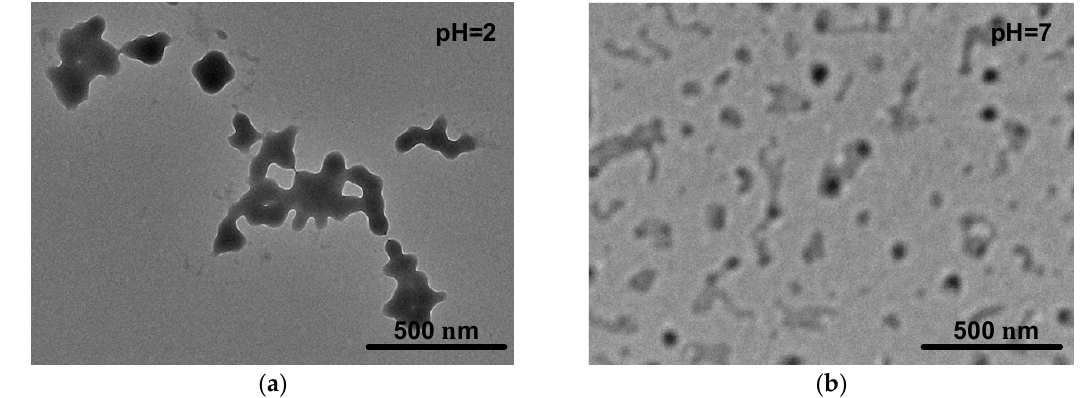
Figure 4. Transmission electron microscope (TEM) images of blank micelles formed by Ad-P1 at different pH conditions ( a ) pH = 2; ( b ) pH = 7.